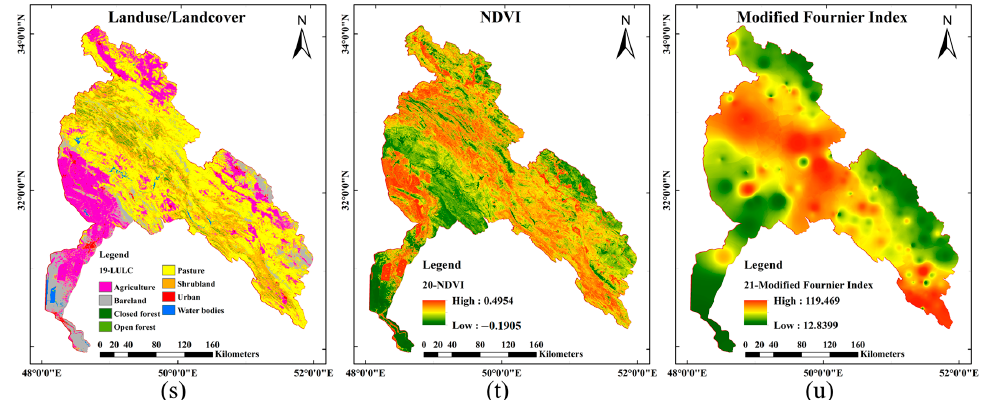
Figure 3. The produced flood conditioning factors for FSM in the Karun basin. ( a ) DEM, ( b ) Slope, ( c ) Aspect, ( d ) Curvature, ( e ) Cross-Sectional Curvature, ( f ) Longitudinal Curvature, ( g ) Convergence Index, ( h ) Valley Depth, ( i ) LS factor, ( j ) Flow Accumulation, ( k ) Terrain Ruggedness, ( l ) Topographic Position Index, ( m ) Modified Catchment Area, ( n ) Stream Power Index, ( o ) Topographic Wetness Index, ( p ) Horizontal Overland Flow Distance, ( q ) Vertical Overland Flow Distance, ( r ) Curve Number, ( s ) Land Use/Land Cover Map, ( t ) Normalized Vegetation Index, and ( u ) Modified Fournier Index.